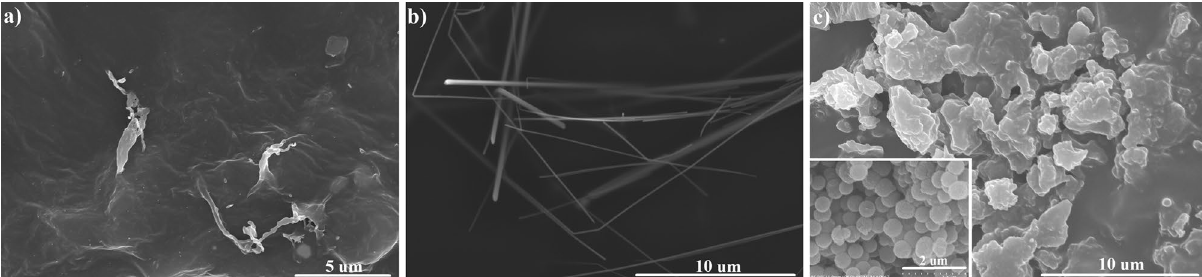
Figure 1. Surface characterization of EDL-based composites. SEM micrographs of EDL/CNT ( a ), EDL/AgNW ( b ) and EDL/MSP ( c ), the latter with the inset showing P(EDOT-OH) microspheres after